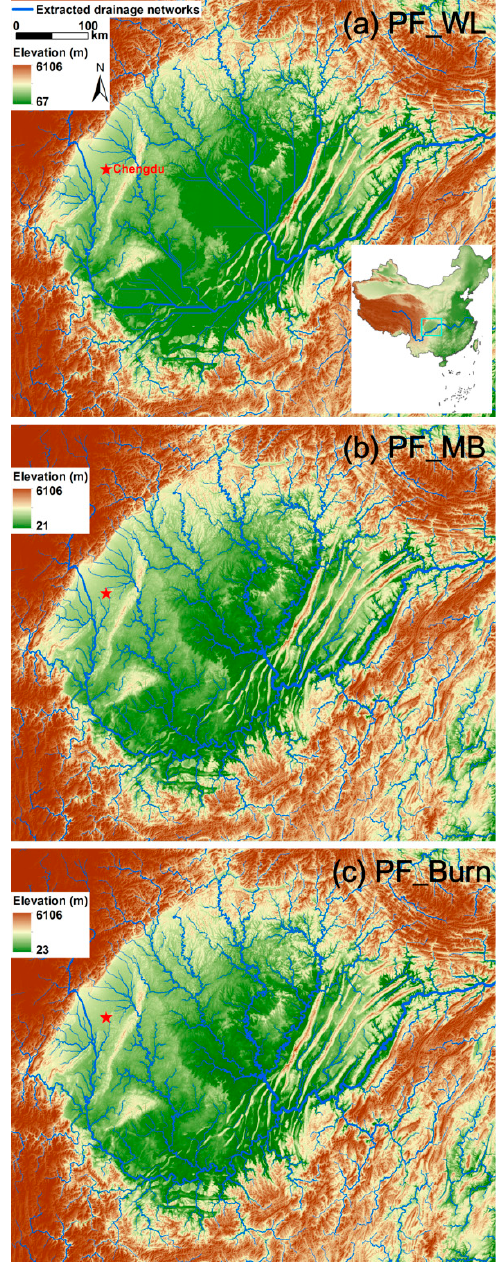
Figure 2. Comparison of the drainage networks derived based on the three depression treatments, overlaid with three different 90 m DEMs of the test region that encloses the Sichuan Basin, South-western China. ( a ) The major drainage networks and the depression-filled DEM obtained based on the PF_WL algorithm. The inset in the lower-right corner shows the topography of China, the Yangtze River, and the box that bounds the test region. ( b ) The major drainage networks derived based on PF_MB and the original DEM. ( c ) The major drainage networks and rectified DEM based on PF_Burn.